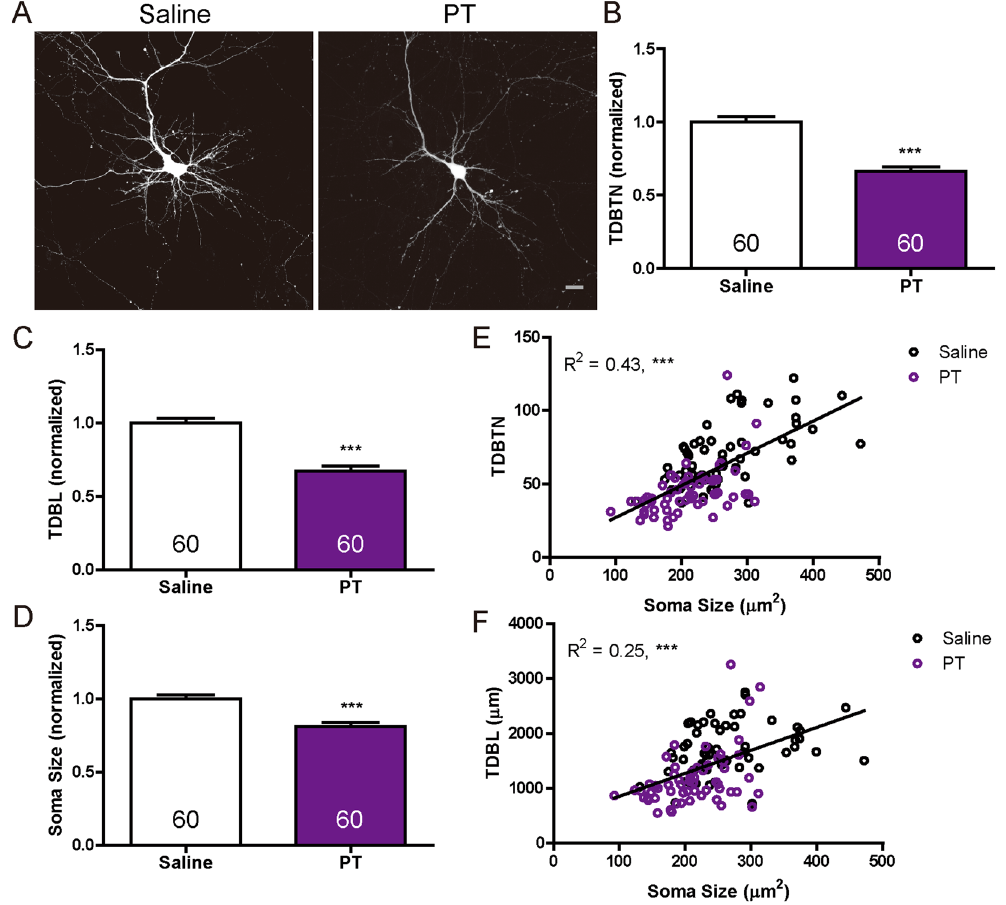
Figure 7. Pyrithiamine significantly reduced TDBTN, TDBL and soma size. ( A ) Representative images of hippocampal neurons treated with saline or Pyrithiamine (PT, 50 μ M) for 48 hours (DIV7 – DIV9). Scale bar: 20 μ m. ( B ) Quantitation of TDBTN: saline (1.00 ± 0.04), PT (0.66 ± 0.03, P < 0.001). ( C ) Quantitation of TDBL: saline (1.00 ± 0.03), PT (0.67 ± 0.03, P < 0.001). ( D ) Quantitation of soma size: saline (1.00 ± 0.03), PT (0.81 ± 0.03, P < 0.001). ( E ) A significant correlation between TDBTN and soma size ( n = 120, R 2 = 0.43, P < 0.001). ( F ) A significant correlation between TDBL and soma size ( n = 120, R 2 = 0.25, P < 0.